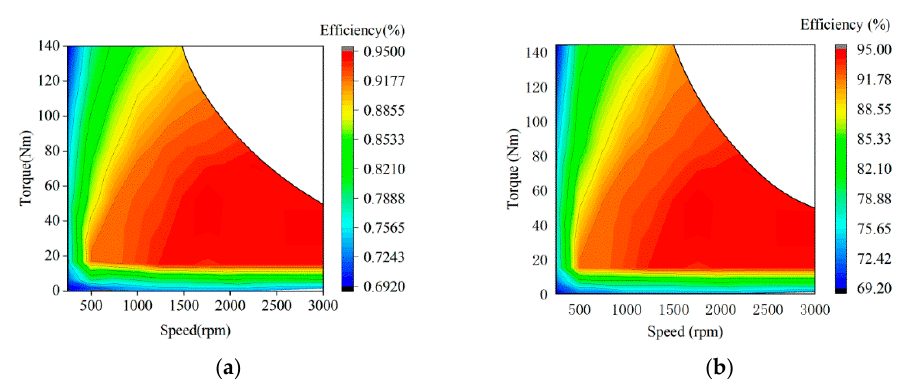
Figure 15. Efficiency map: ( a ) initial motor; ( b ) proposed motor.